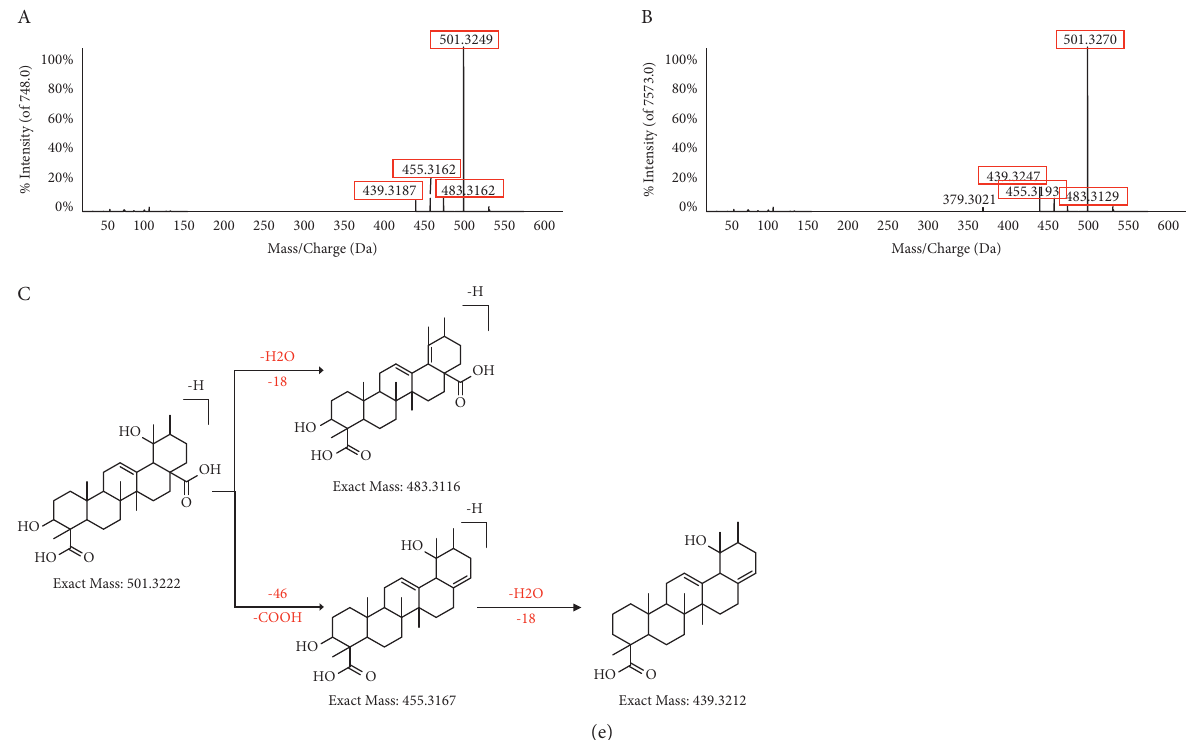
Figure 4: MS/MS of IRC and standard compounds. (a) Ilexsaponin A, (b) pedunculoside, (c) rotundic acid, (d) kudinoside H, and (e) ilexgenin A (A: MS/MS of IRC; B: MS/MS of standard compounds; C: mass spectrum fracture mode).